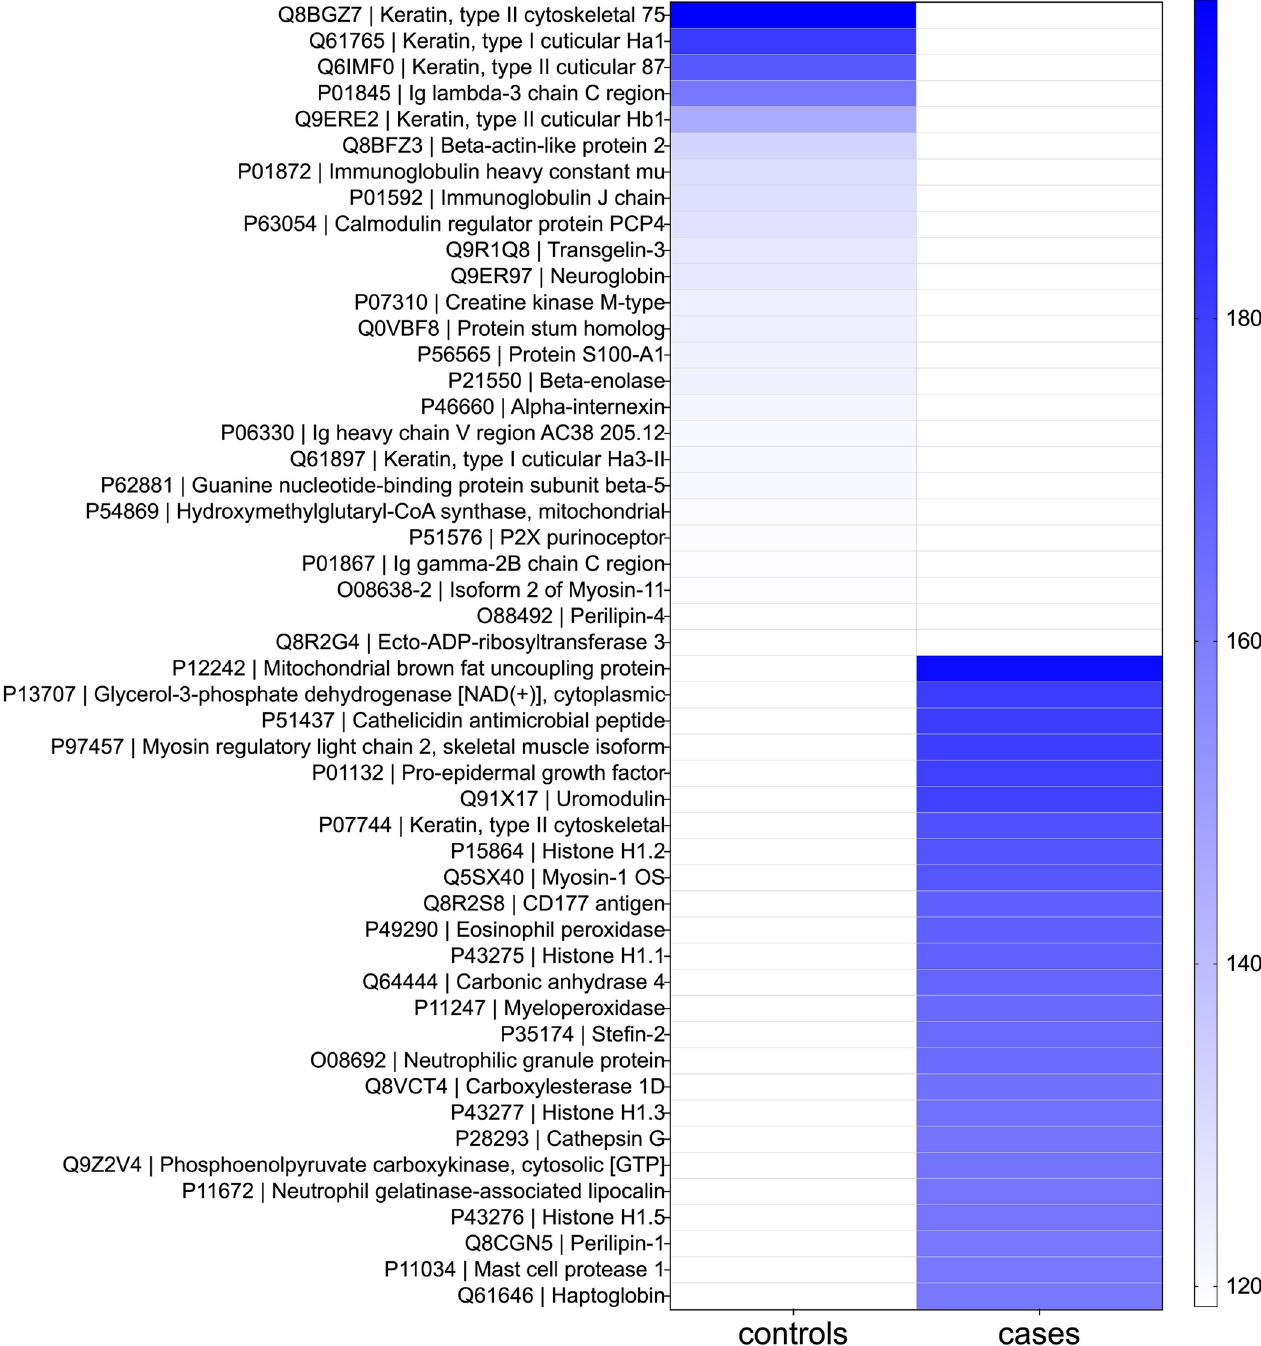
Fig 1. Top 25 most abundant proteins. Heat map shows mean protein abundances from each replicate group. Controls, tissue extract-injection group (n = 4), Cases, egg-injection replicates (n = 4). Proteins are shown as Accession number | Description.